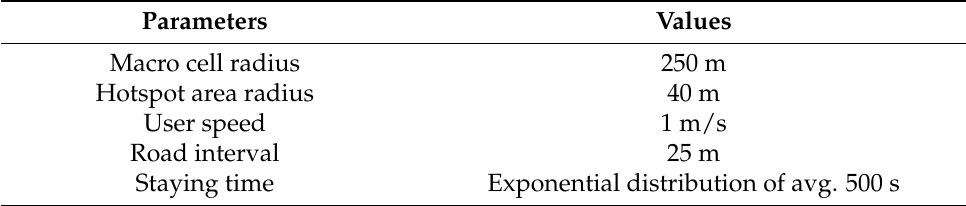
Figure 2. The user mobility model. Table 2. The mobility